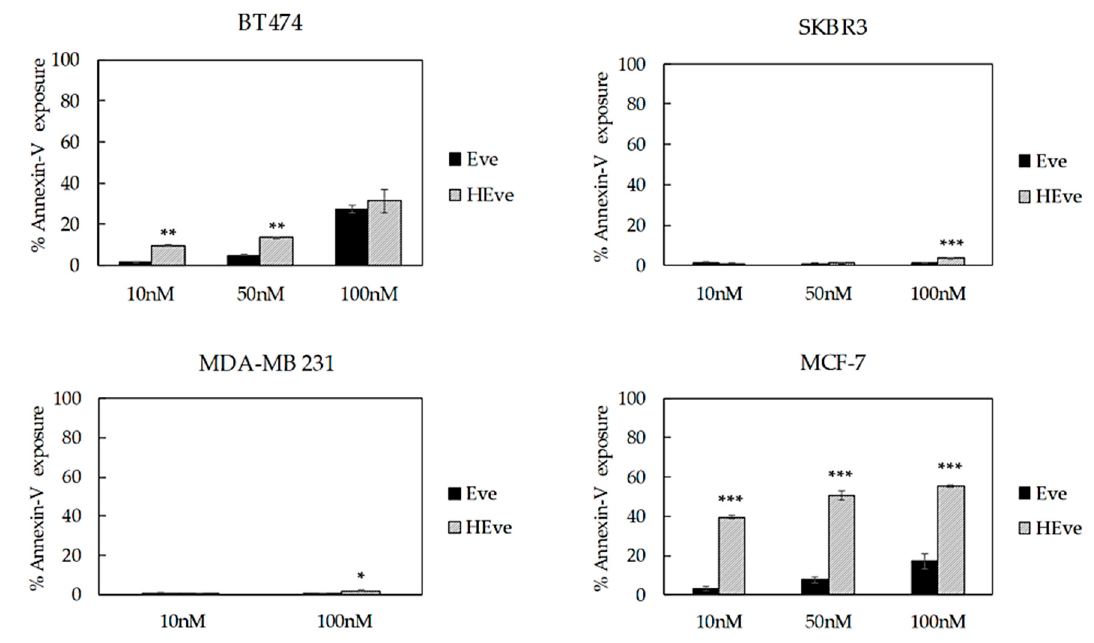
Figure 6. Cell death assay of BT474, SKBR3, MDA-MB 231, and MCF-7 cells treated with increasing concentrations of nanoformulated Eve (HEve; 10, 50, and 100 nM) or Eve for 72 h. Reported values are the mean of three replicates ± s.e., normalized to cell proliferation of untreated cells. * p < 0.005; ** p < 0.0005; *** p < 0.0001 (Student’s t -test).